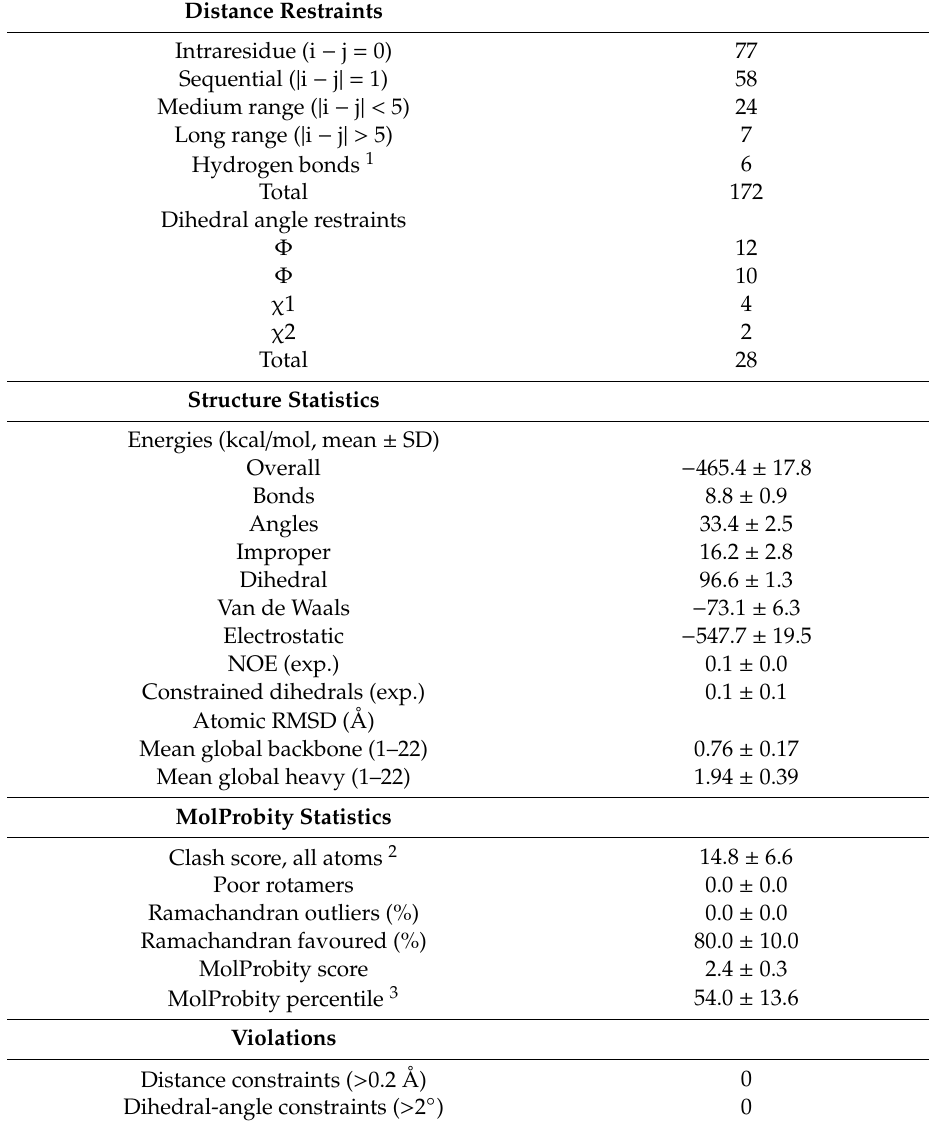
Table 2. Statistical analysis of SxIIIC NMR solution